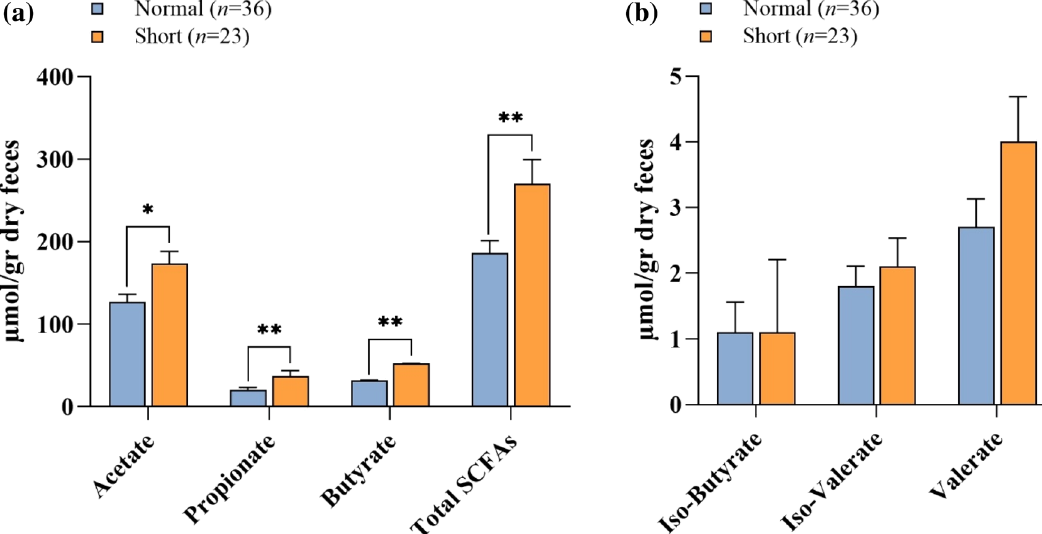
Figure 1. Differences in SCFA concentrations in the Normal and Short groups. The SCFAs measured are acetate, propionate, and butyrate ( a ), and iso-butyrate, iso-valerate, and valerate ( b ). Results are shown as mean ± SE. A Mann–Whitney test was used to compare differences between groups. *p < 0.05, **p < 0.01.